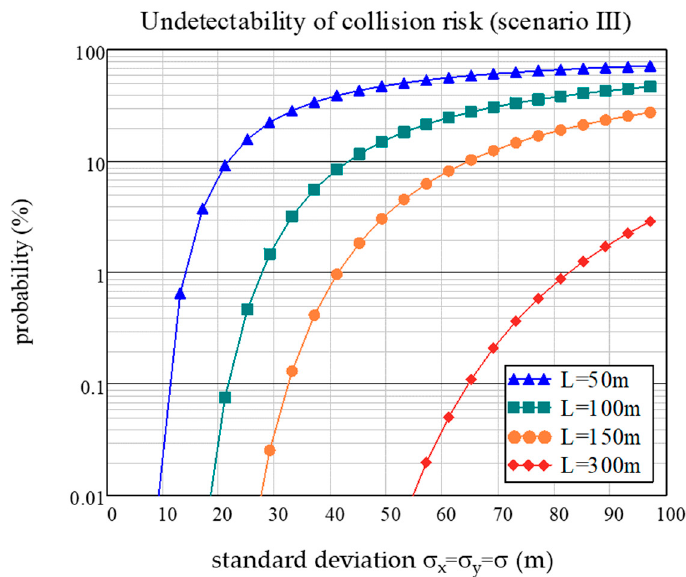
Figure 8. Undetectability of existing collision risks for exemplary diameters L of ship domains dependent on the assumed standard deviation of position error.